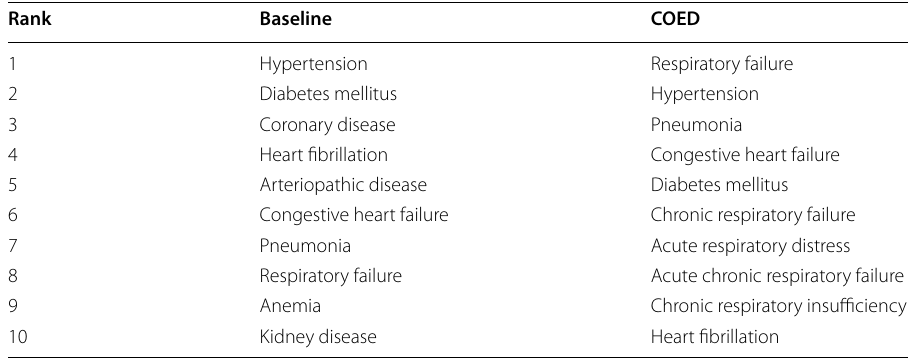
Table 3 Selection of top ten results for diseases and disorders